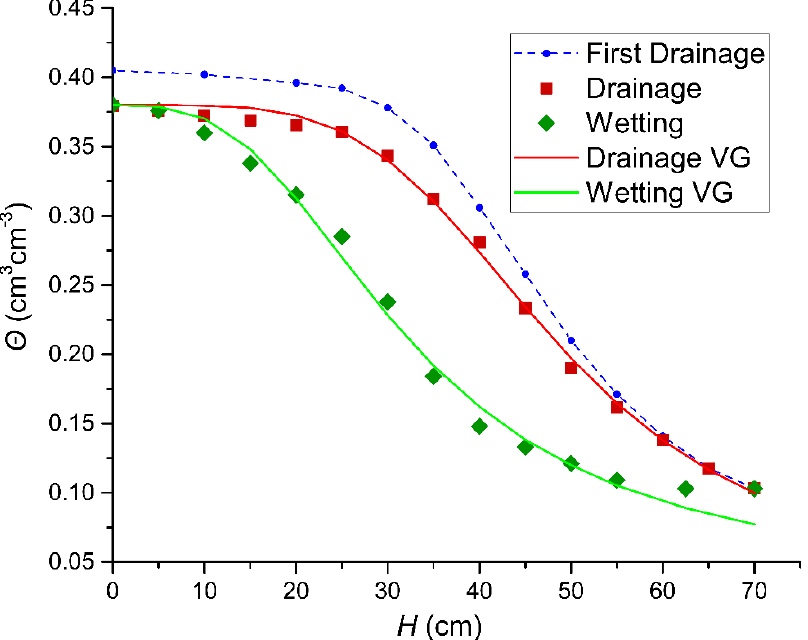
Figure 1. The experimental data for the boundary wetting and drying curves of the hysteretic loop (points) and the fitted curves according to the Mualem–van-Genuchten model (VG). The corresponding values of parameters of the Mualem–van-Genuchten model are presented in Table 1. Table 1. The values of the parameters of the Mualem–van-Genuchten model obtained according to a curve-fitting procedure (RETC program) on experimental measurements and the measured Κ s.